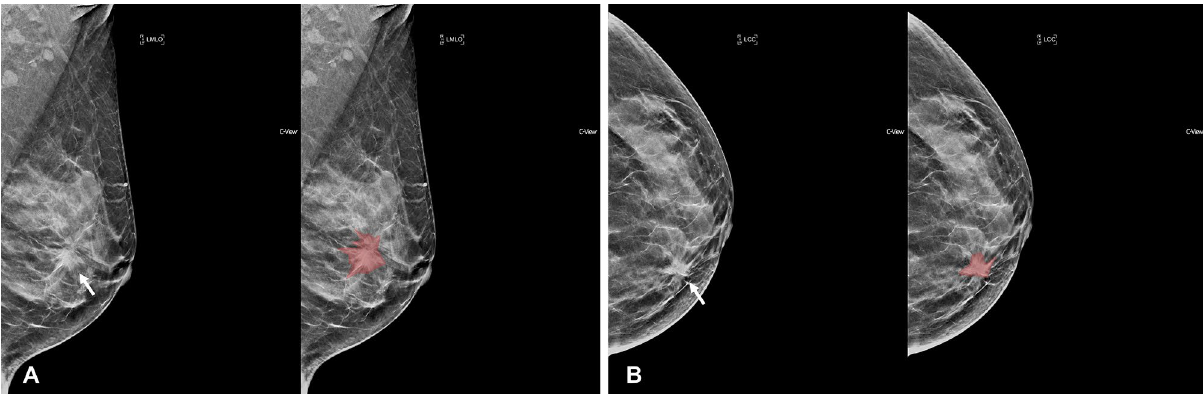
Figure 3. Segmentation example 2. Example of tumor segmentation on synthetic mammography. The synthetic mediolateral oblique (A) and craniocaudal (B) views of a 47-year-old female diagnosed with the luminal subtype of breast cancer. The breast lesion appears as a spiculated mass with architectural distortion